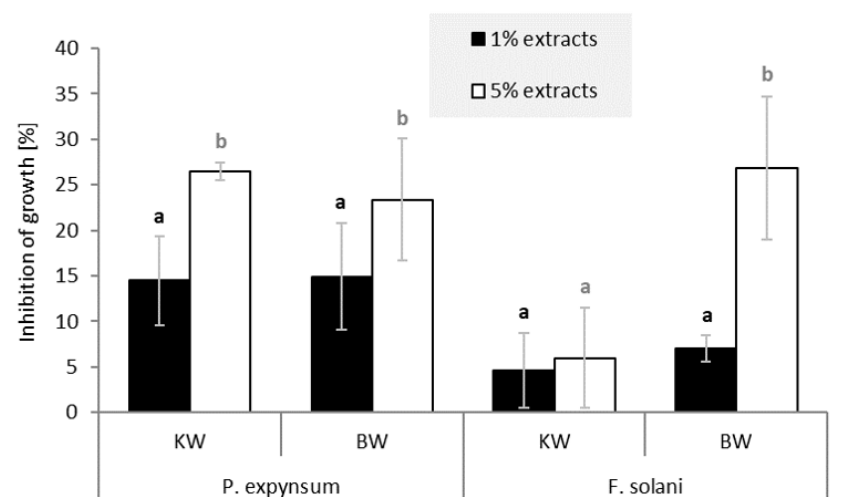
Figure 7. Growth inhibition of molds Penicillium expynsum and Fusarium solani by crude hydrophilic extracts of silver fir ( Abies alba ). The columns represent the average inhibition achieved with 1% and 5% solutions (DMSO, w/v ) of knotwood (KW) and branchwood (BW) extracts. a,b Different letters on the error bars of the same series of columns indicate statistically significant differences at a 95% confidence level (LSD test).